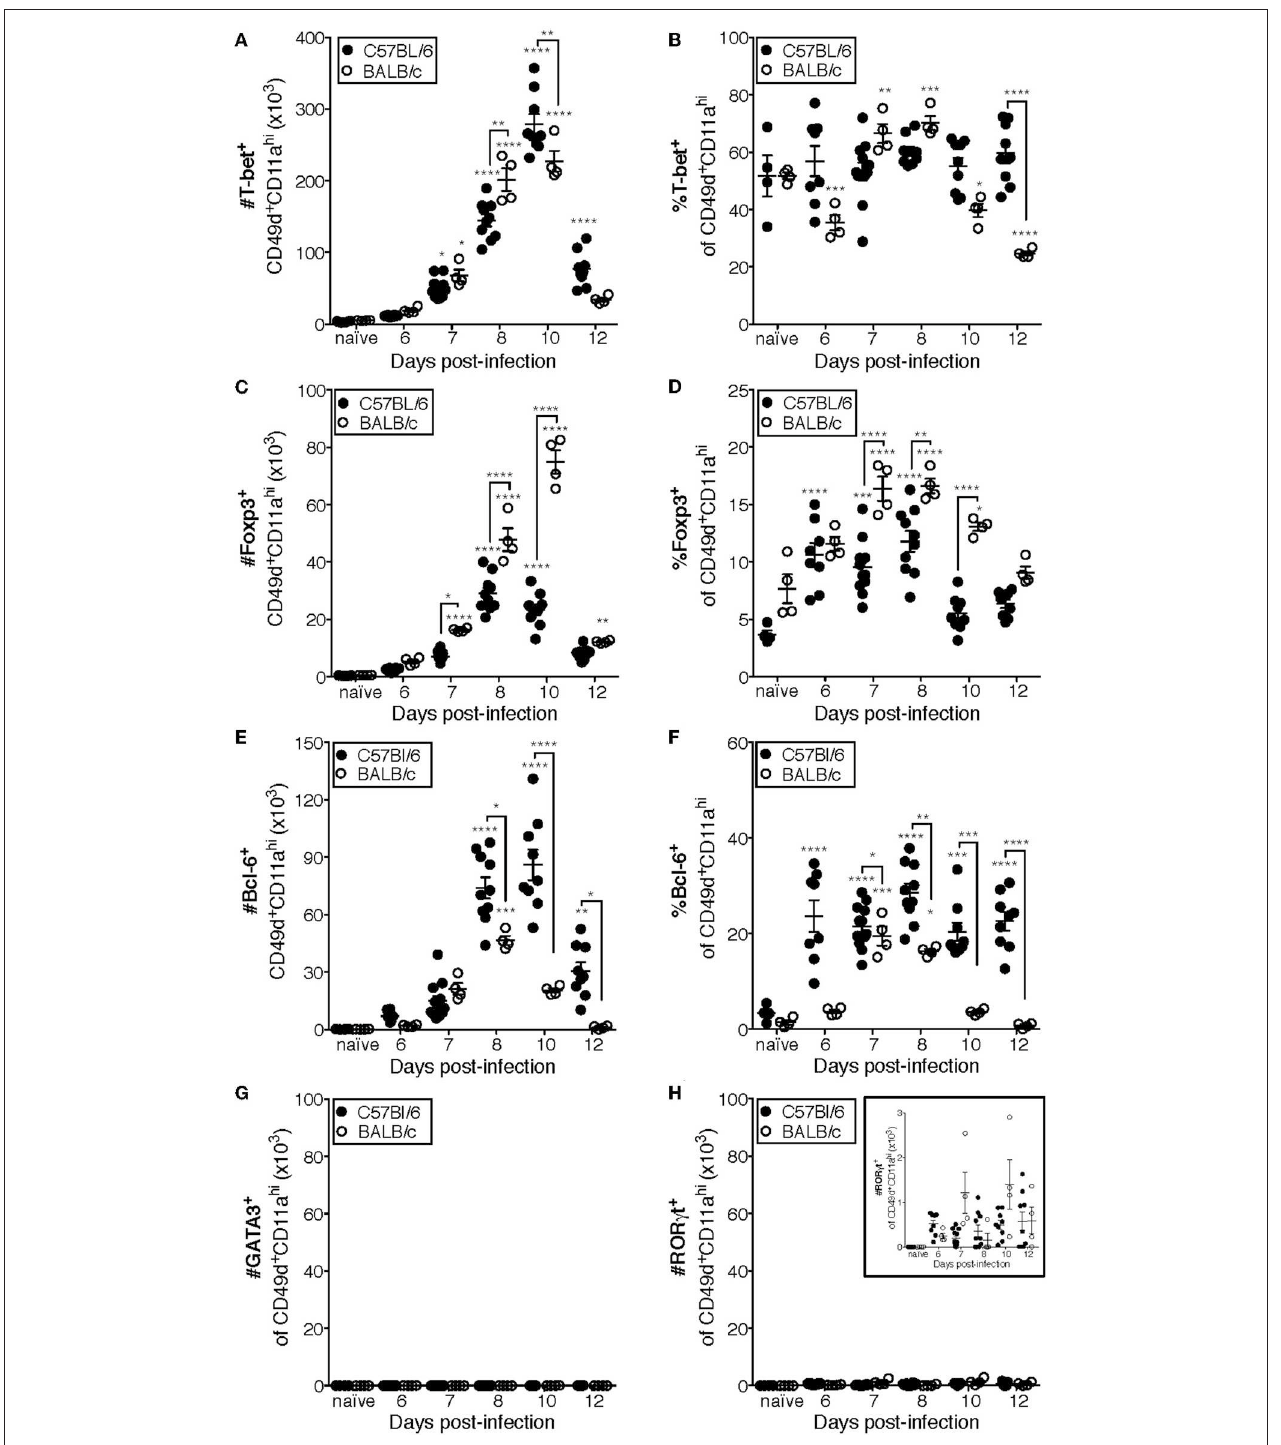
FIGURE 4 | Most IAV-specific CD4T cells accumulating in the lungs of C57Bl/6 and BALB/c mice following infection express T-bet, Bcl-6, or Foxp3. C57Bl/6 and BALB/c mice were infected with a 0.05LD 50 inoculum of IAV-PR8. Lungs were subsequently harvested at the indicated time post-infection and the cells stained for surface expression of CD11a CD49d and CD4, fixed, permeabilized and then stained intracellularly for T-bet (A,B) , Bcl-6 (C,D) , Foxp3 (E,F) , GATA-3 (G) , or ROR γ t (H) expression. Cells were then analyzed by flow cytometry. The numbers and frequencies of T-bet + , Bcl-6 + , Foxp3 + , GATA-3 + , or ROR γ t + subsets of CD49d + CD11a hi CD4 + cells are shown. Each point represents one mouse and mean and SEM are shown. Data are representative of at least three independent experiments and n = 4–9 mice per time point. * p < 0.05; ** p < 0.01; *** p < 0.001; **** p < 0.0001; asterisks directly above data points indicate significance relative to naïve values; asterisks above brackets indicate significance between bracketed